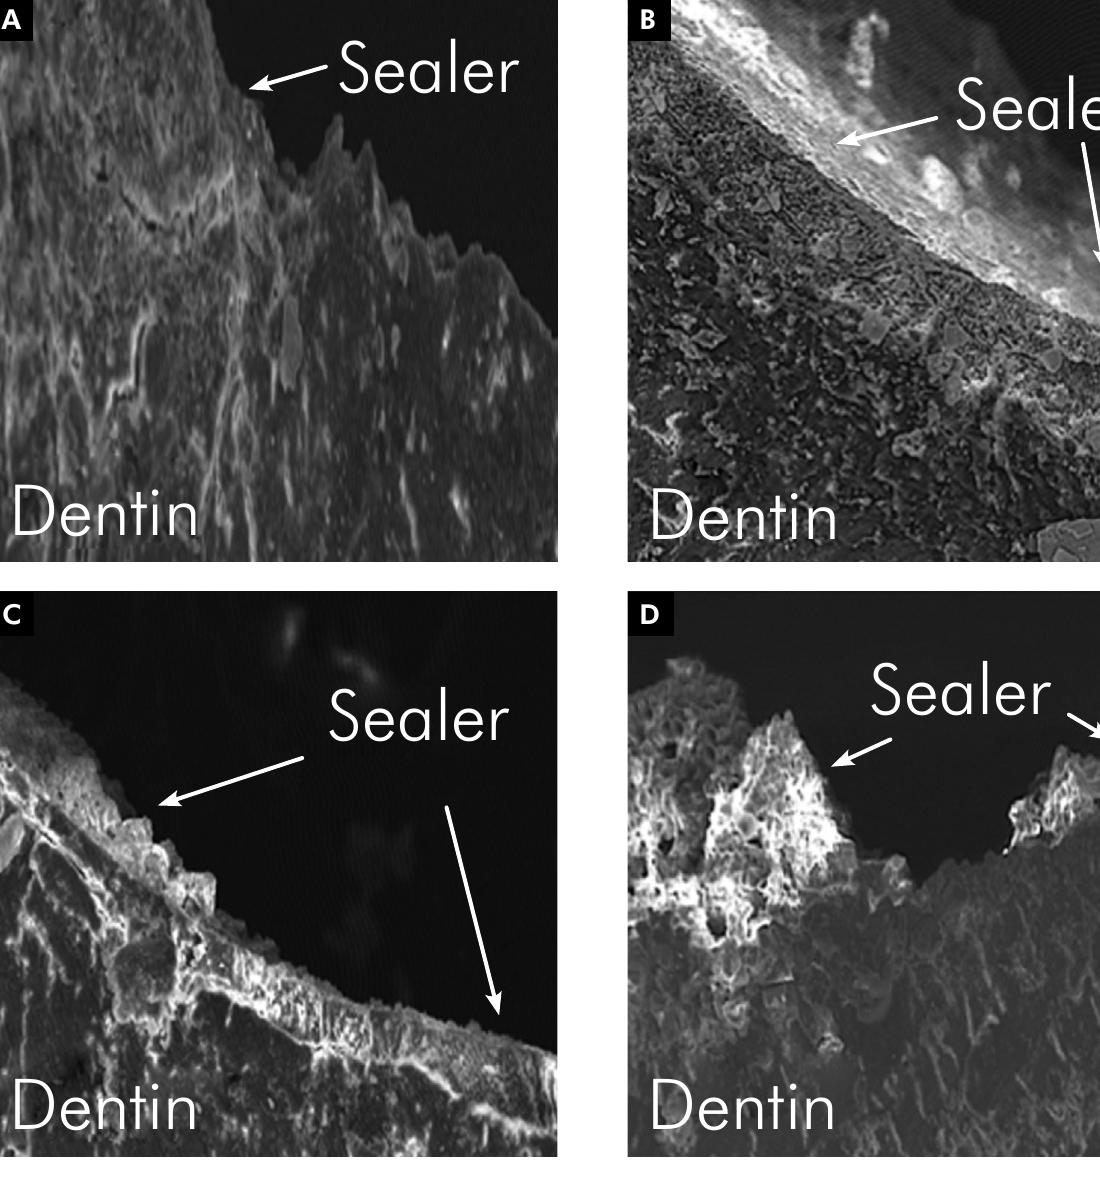
Figure 2. Scanning electron micrographs depict representative failure modes for each corresponding type of failure. A. Adhesive /S-D, B. Adhesive/ S-C, C. Cohesive, D. Mixed (GP= Gutta-percha, RES=Resilon, S-D= Between sealer and dentin, S-C=Between sealer and core